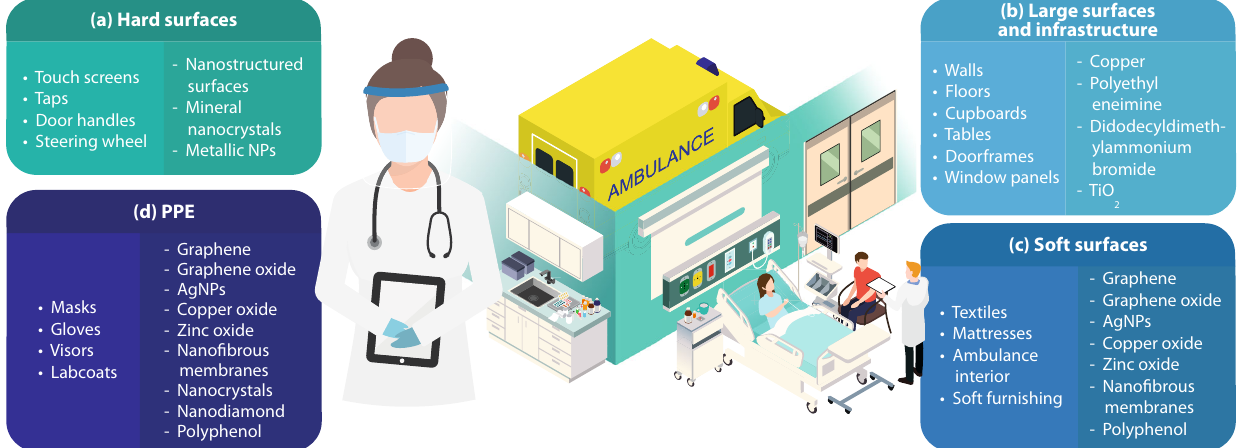
Fig. 3 A hospital composition illustrating examples where anviral surfaces and coatings could be bene fi cial. Four classes of surfaces are shown; a hard surfaces such as touch screens and door handles, b large area and infrastructure such as walls, fl oors and tables; c soft surfaces including textiles and ambulance interior and d PPE including masks, gloves, visors and